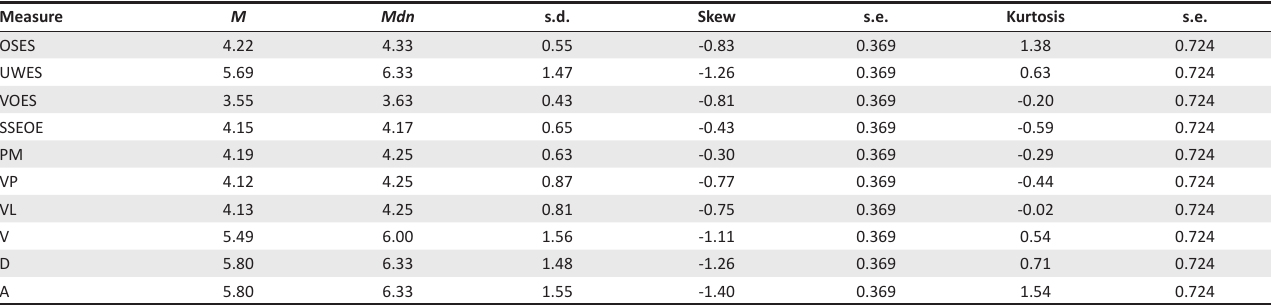
TABLE 1: Descriptive statistics for the measures. Measure M